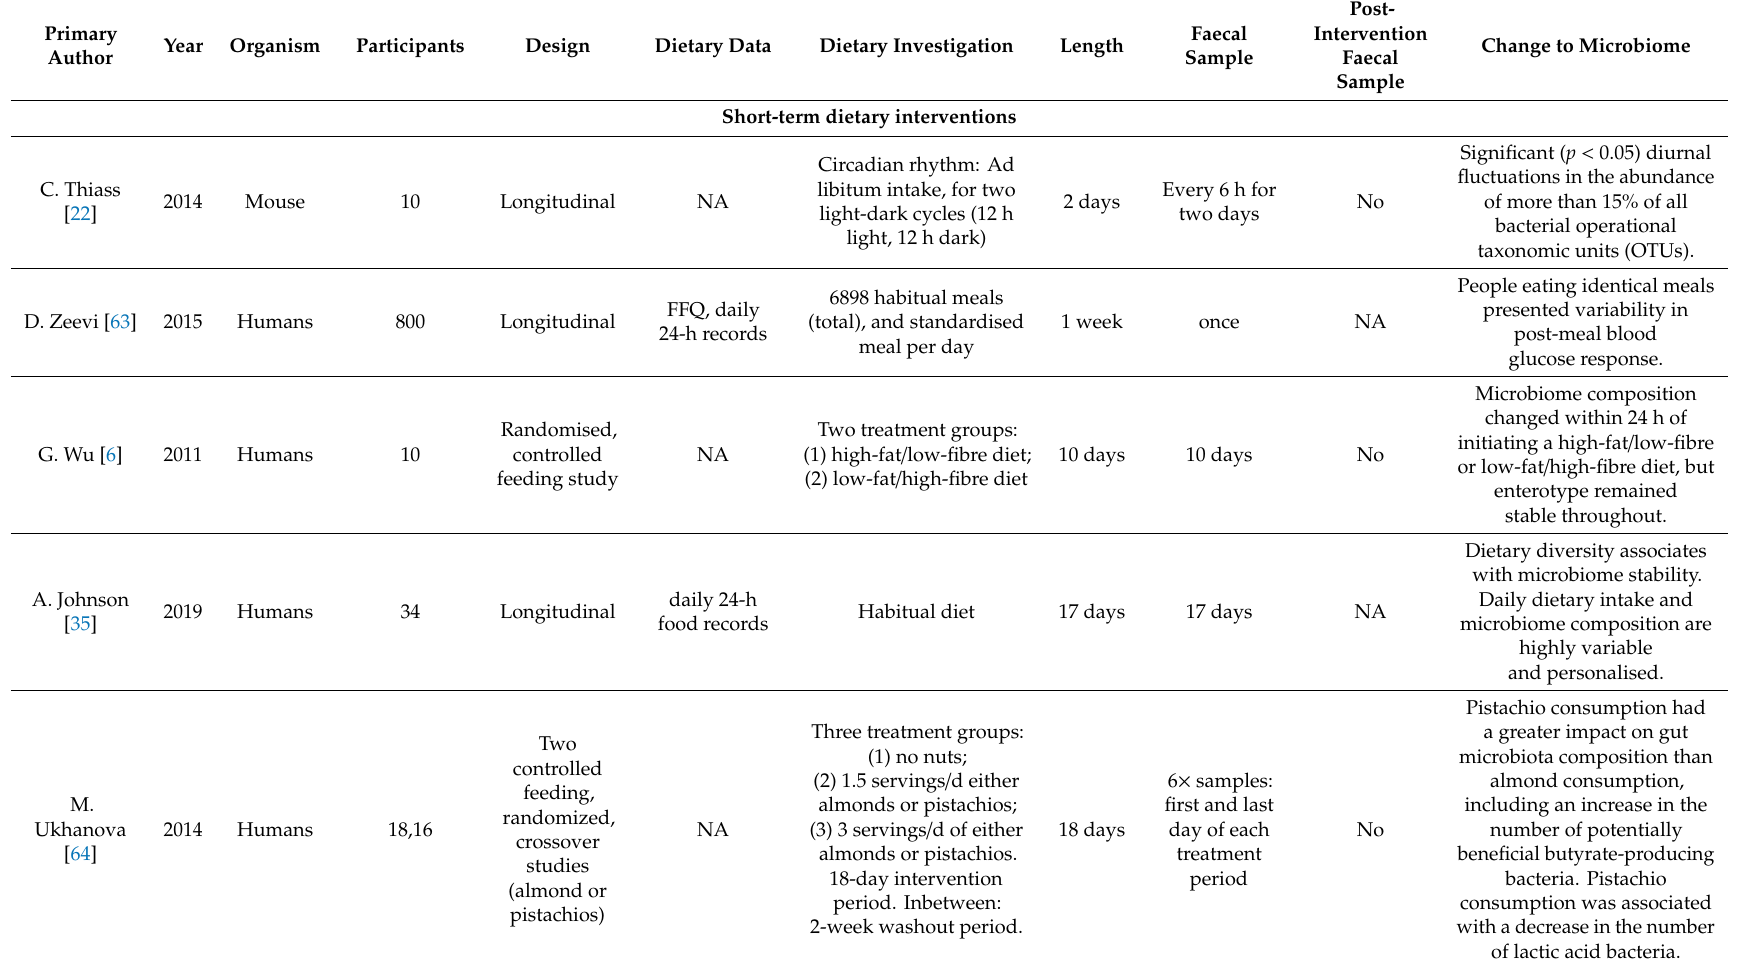
Table 1. Short-term and Long-term Dietary Studies and the Gut